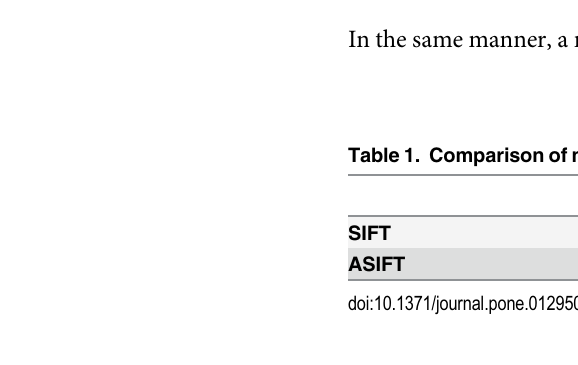
Fig 4. Comparison of SIFT and ASIFT on the same sample. (a) Result of the SIFT algorithm. (b) Result of the ASIFT algorithm.